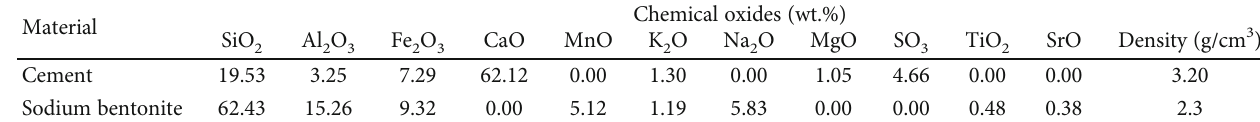
Table 1: Chemical composition of cement and sodium